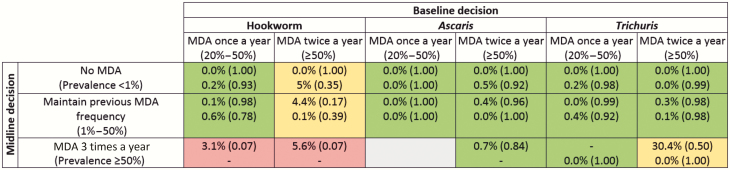
Prevalence of moderate to heavy soil-transmitted helminth infection in school-aged children (SAC) after 10 years of treatment, under recommended updates to treatment guidelines of 75% community-wide coverage. Results in each cell have Imperial College London (ICL) results at the top and Erasmus University Medical Center (EMC) below. Figures in parentheses are the probability of measuring a prevalence of medium- and high-intensity infections <1% from a sample of all SAC. Highlighted by achievement (green) or otherwise (red) of 1% prevalence goal, or varying predictions between models (yellow), in various transmission settings. Results in each cell have ICL results at the top and EMC below. Figures in brackets are the probability of measuring a prevalence of medium- and high-intensity infections <1% from a sample of all SAC. Decisions are based on measured prevalence of infection and correspond with World Health Organization recommendations [1]. The gray box indicates that no villages fell into those categories in either EMC or ICL models. Abbreviation: MDA, mass drug administration.